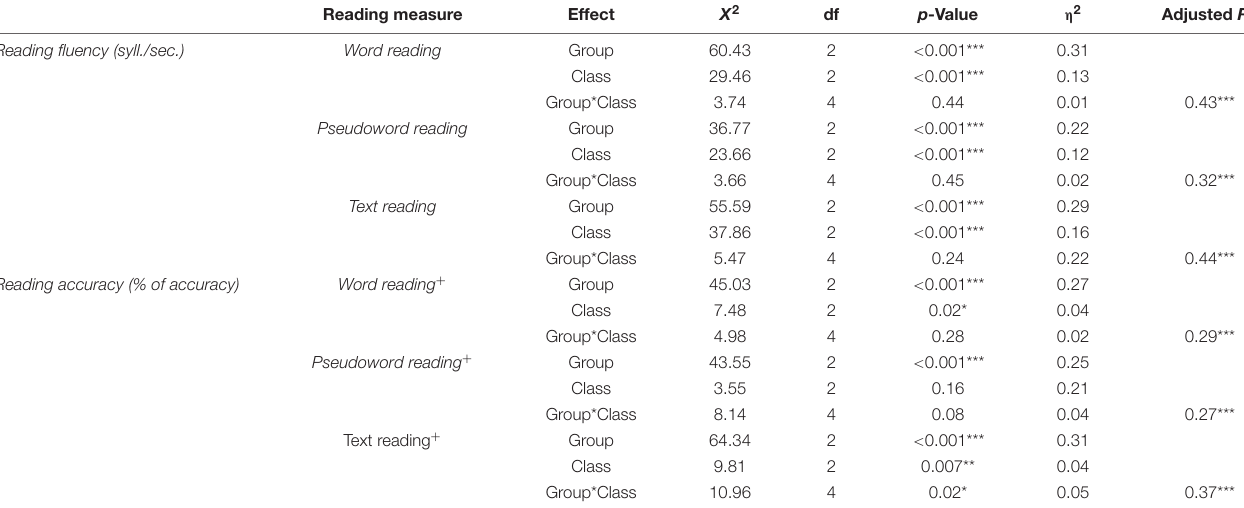
FIGURE 2 | Reading performances of monolingual Good Readers (mGR), minority-language children (MLC), and monolinguals Poor Readers (mPR). Panels (A,C,E) display reading accuracy (percentage of accuracy), while panels (B,D,F) display reading fluency (syllables/seconds). TABLE 3 | Simple and interaction effects emerged by the Generalized Linear Models (GLMs) run on reading measures. Reading measure Effect X 2 df p -Value η 2 Adjusted R